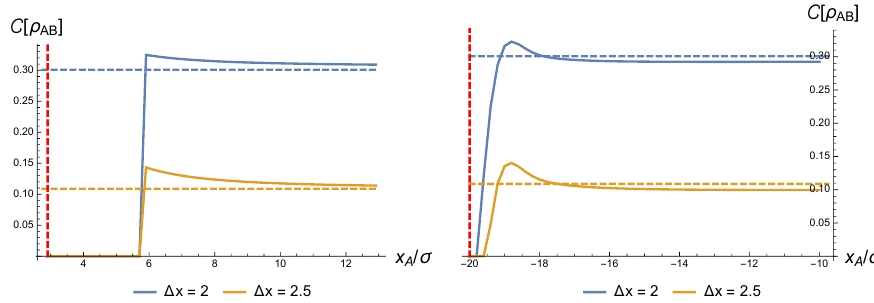
Figure 5 . Concurrence for a BHC mirror (in red at time t when the detector is temporally peaked) for various (cid:12)xed detector separations as a function of position of detector A with (cid:20) = 0 : 25, (cid:10) = 1 ; (cid:27) = 1. From left to right: Left v H = 0, the \earlier"time t = (cid:0) 20. Right v H = 0, the \late" time t =